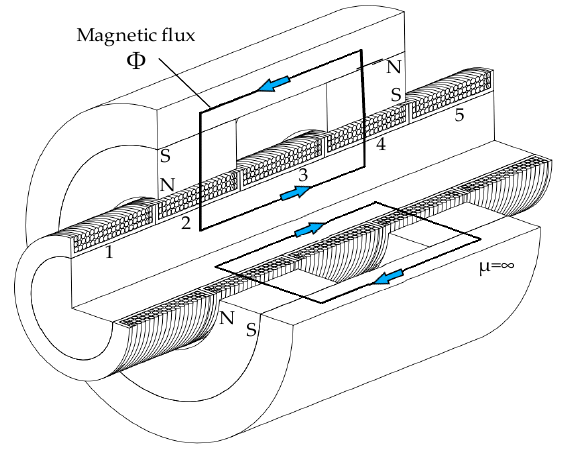
Figure 5. Magnetic circuit of the CDCLM.